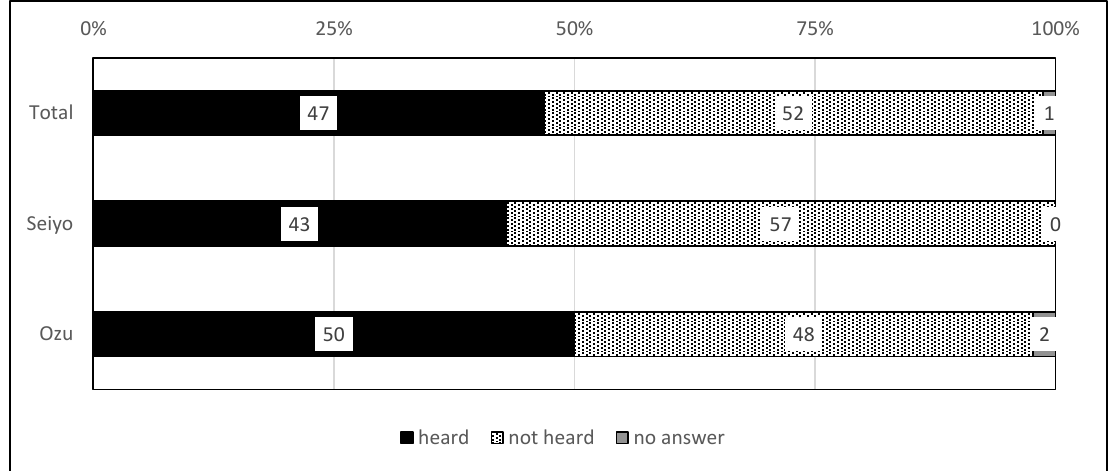
Figure 11. Rate at which evacuation instructions were heard (%), n = 79.